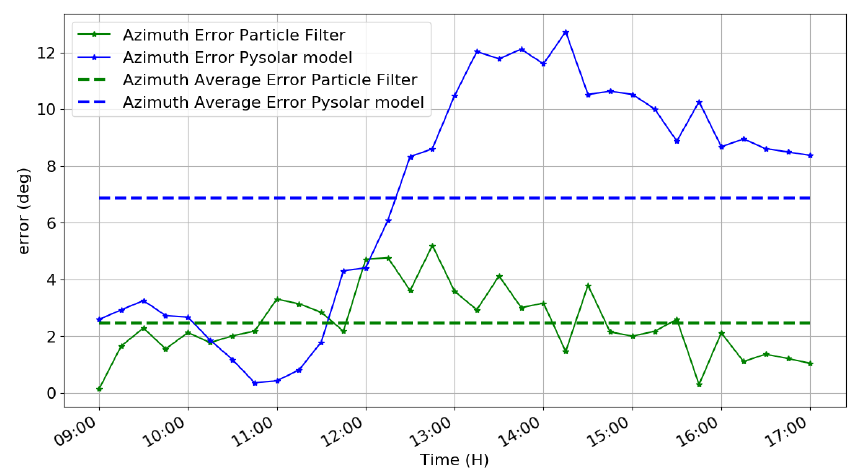
Figure 28. Solar azimuth